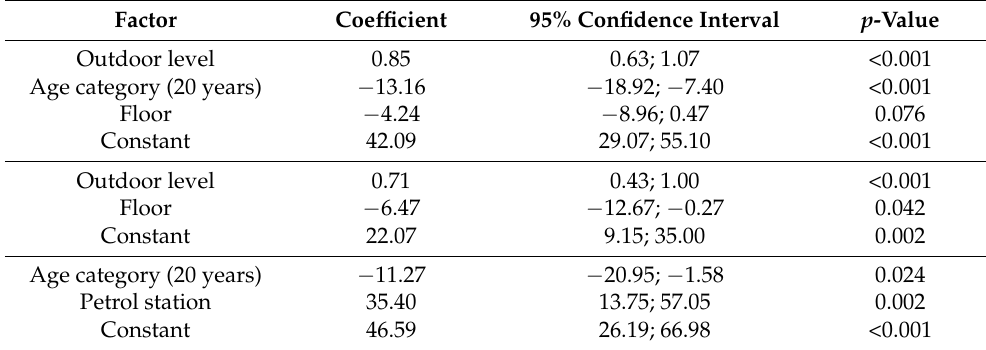
Table 1. Building associated factors and outdoor sources relevant for NO 2 levels. Coefficients in µ g/m 3 .